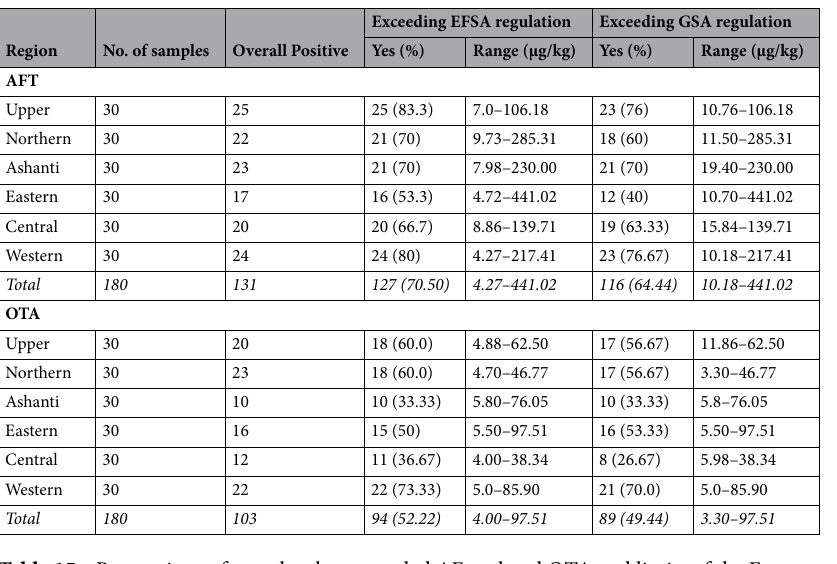
Table 15. Proportions of samples that exceeded AFtotal and OTA and limits of the European Food Safety Authority (EFSA) and Ghana Standard Authority (GSA). Total values are in [italics]. European Union Food Safety (EFSA) limit for AF Total = 4 µg/kg. European Union Food Safety (EFSA) limit for OTA = 4 µg/kg. Ghana Standards Authority (GSA) limit for AF Total = 10 µg/kg. Ghana Standards Authority (GSA) limit for OTA = 5